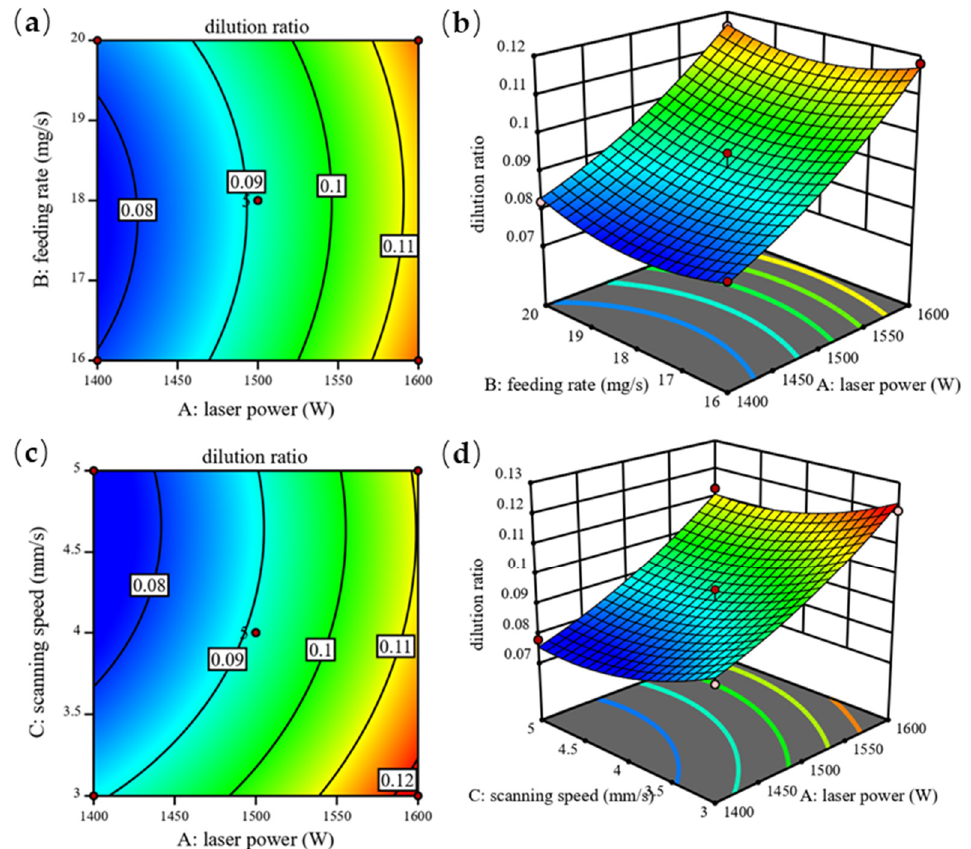
Figure 5. Contour lines for effects of the interactions of ( a ) laser power and powder feeding rate and ( c ) laser power and scanning speed on the dilution ratio. Impact of the correlation between ( b ) laser power and powder feeding rate and ( d ) laser power and scanning speed on the response surface of the dilution ratio.